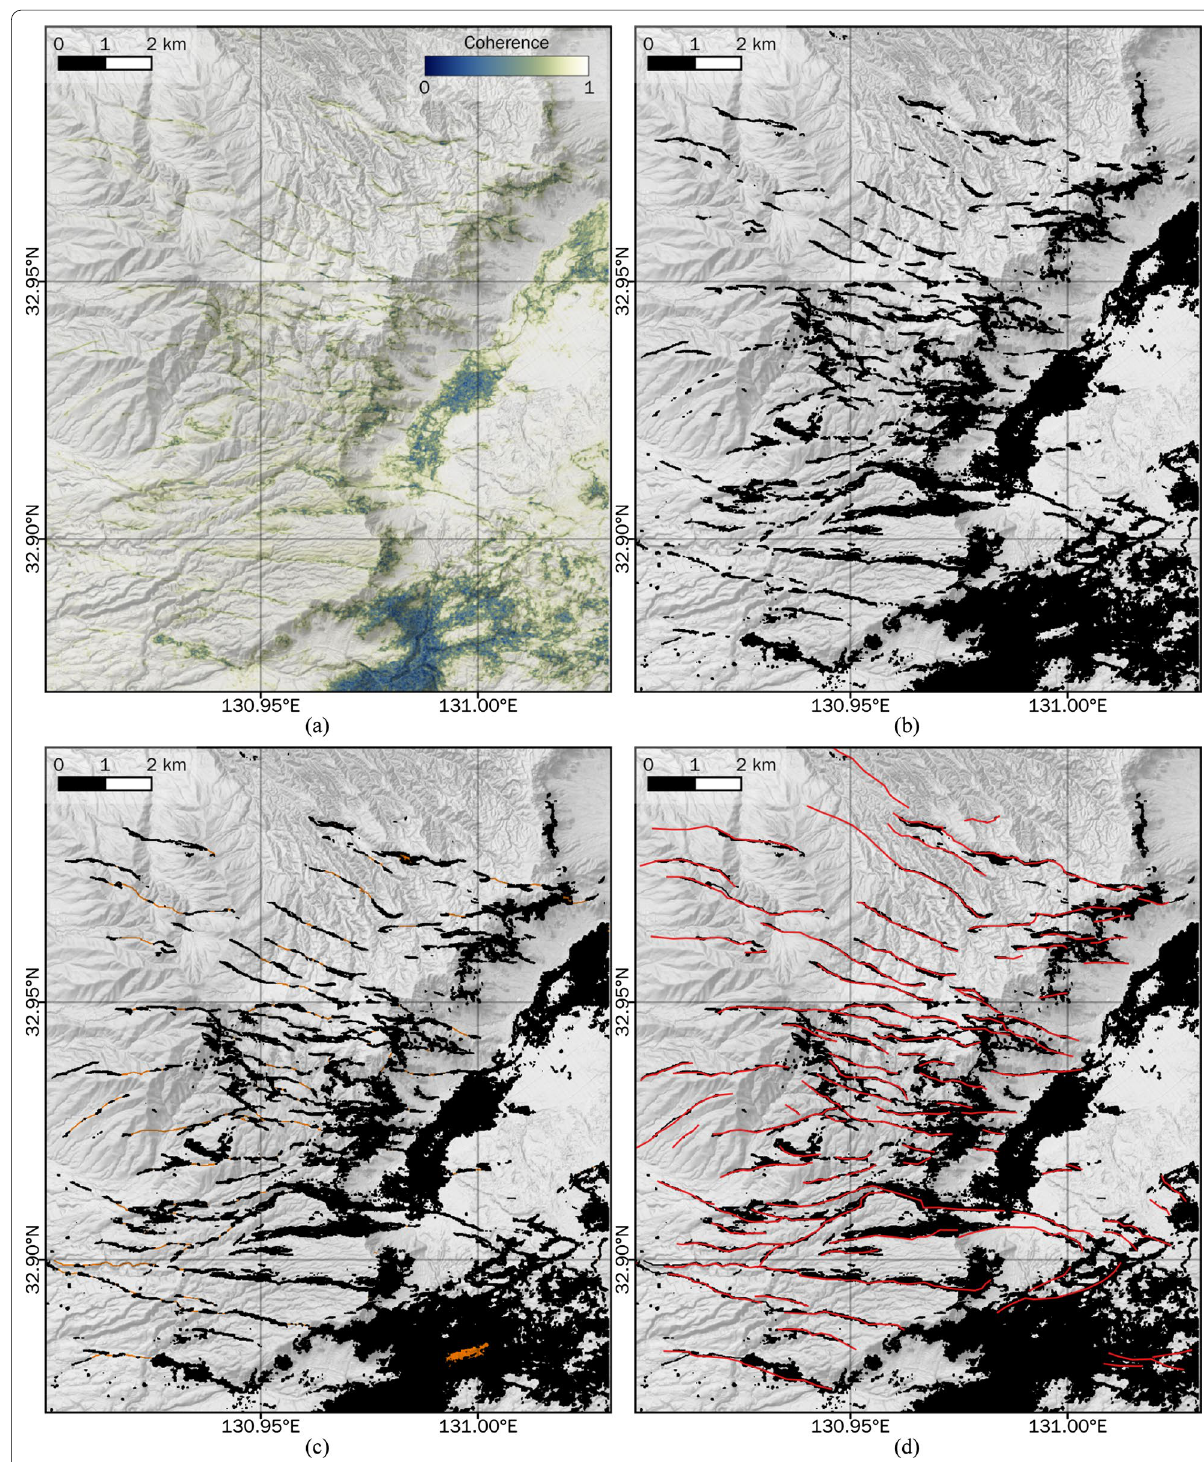
Fig. 7 a Average phase noise coherence estimate. b Base of the common mask image. Black pixels are masked. c Crafted common mask image. The manually added mask is highlighted by orange color. d Crafted common mask image overlaid by the displacement lineaments (red lines) identified by Fujiwara et al. (2016,